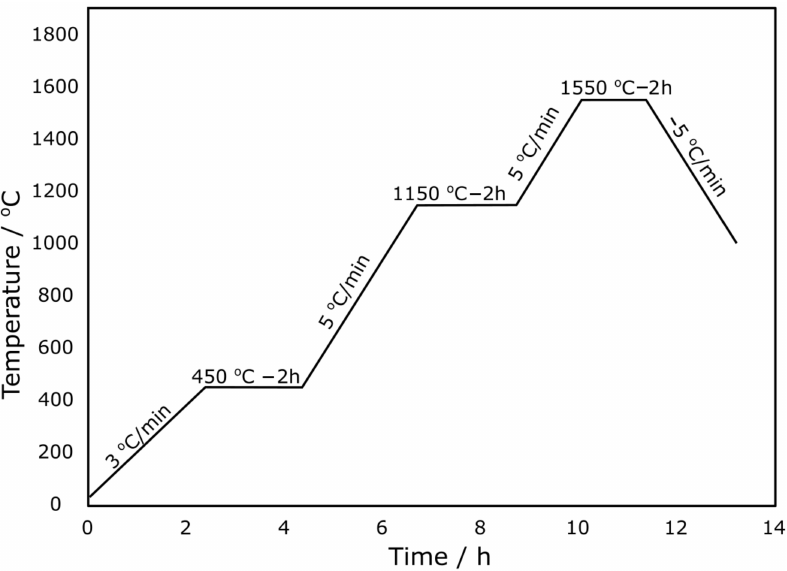
Figure 7. Elaborated profile of temperature increases while sintering the NiO–5CBCY anode sample.